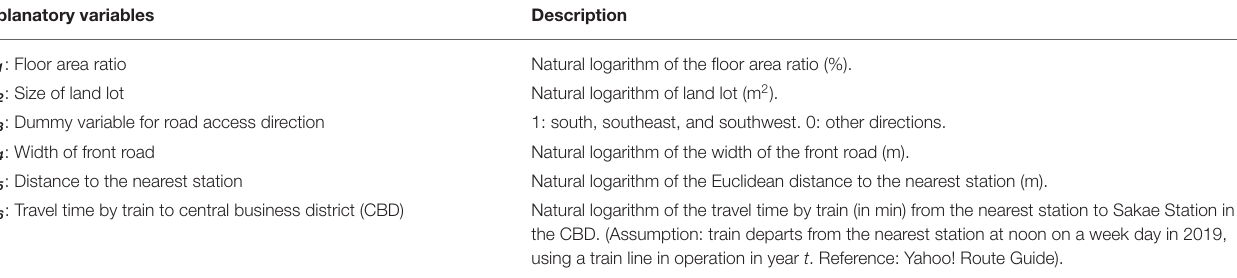
TABLE 1 | Explanatory variables.